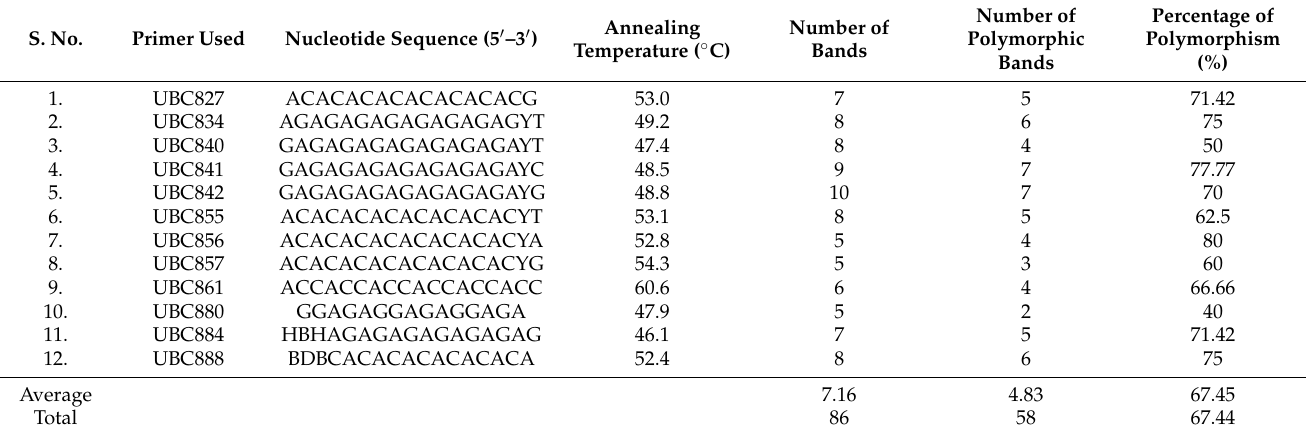
Table 4. ISSR primers used, polymorphic bands, and polymorphism percentage detected in the present